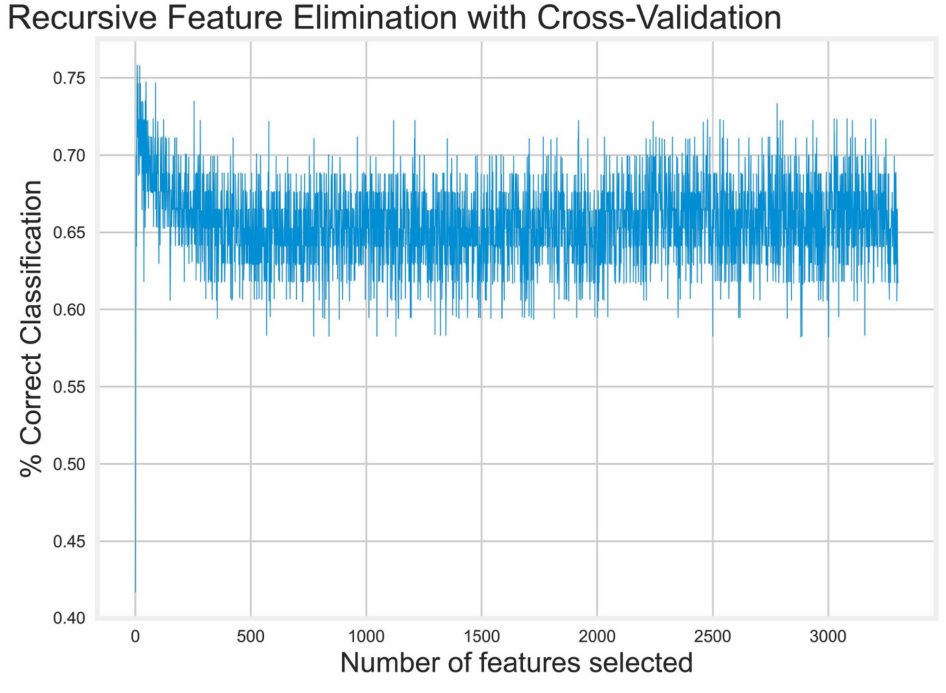
Figure 5. Feature Importance.